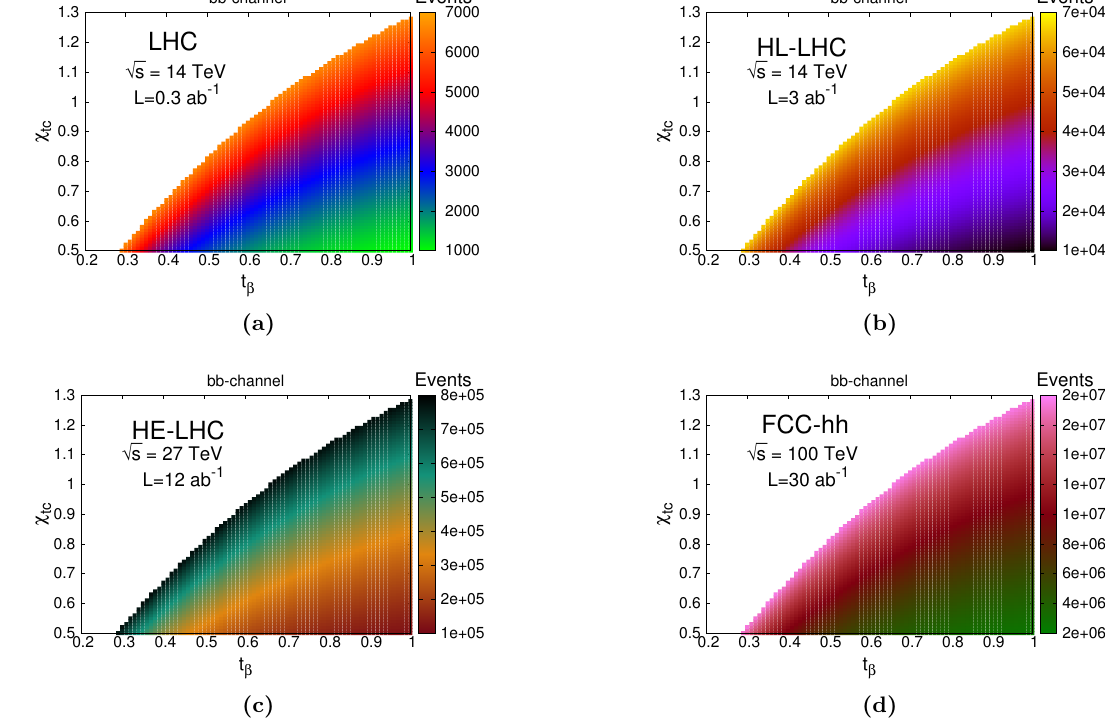
Figure 4. Number of signal events for the bb -channel in the t (cid:12) (cid:0) (cid:31) tc plane: (a) LHC to L =0.3 ab (cid:0) 1 , (b) HL-LHC to L =3 ab (cid:0) 1 , (c) HE-LHC to L =12 ab (cid:0) 1 and (d) FCC-hh L =30 ab (cid:0) 1